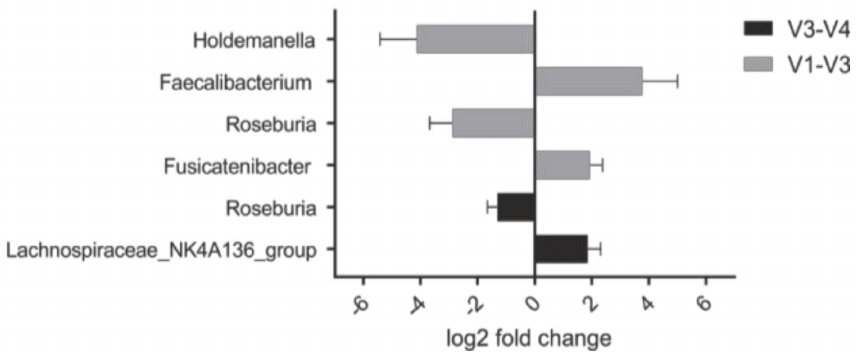
Figure 4. The abundance of certain taxa at baseline is higher in those that experience a clinical response to PHGG. These taxa almost exclusively belong to the order of Clostridiales. Notably, Roseburia is detected in both datasets. Negative binomial Wald-test comparing two groups defined by an increase in stool frequency per day larger or smaller than the median increase in this study population; all, p <